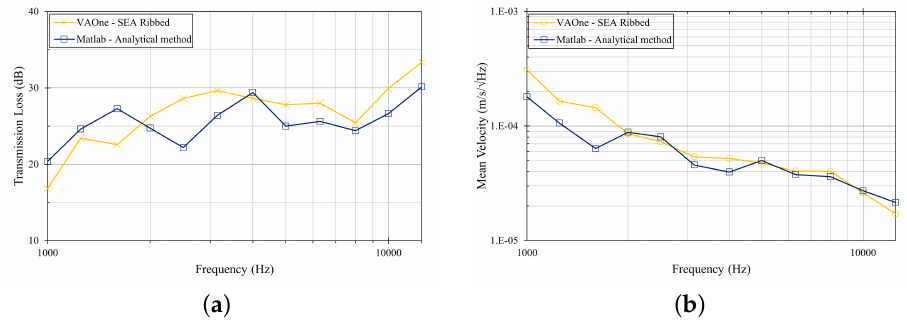
Figure 22. Vibro-acoustic responses of a panel with conventional stringers: ( a ) sound transmission loss and ( b ) space-average mean vibration